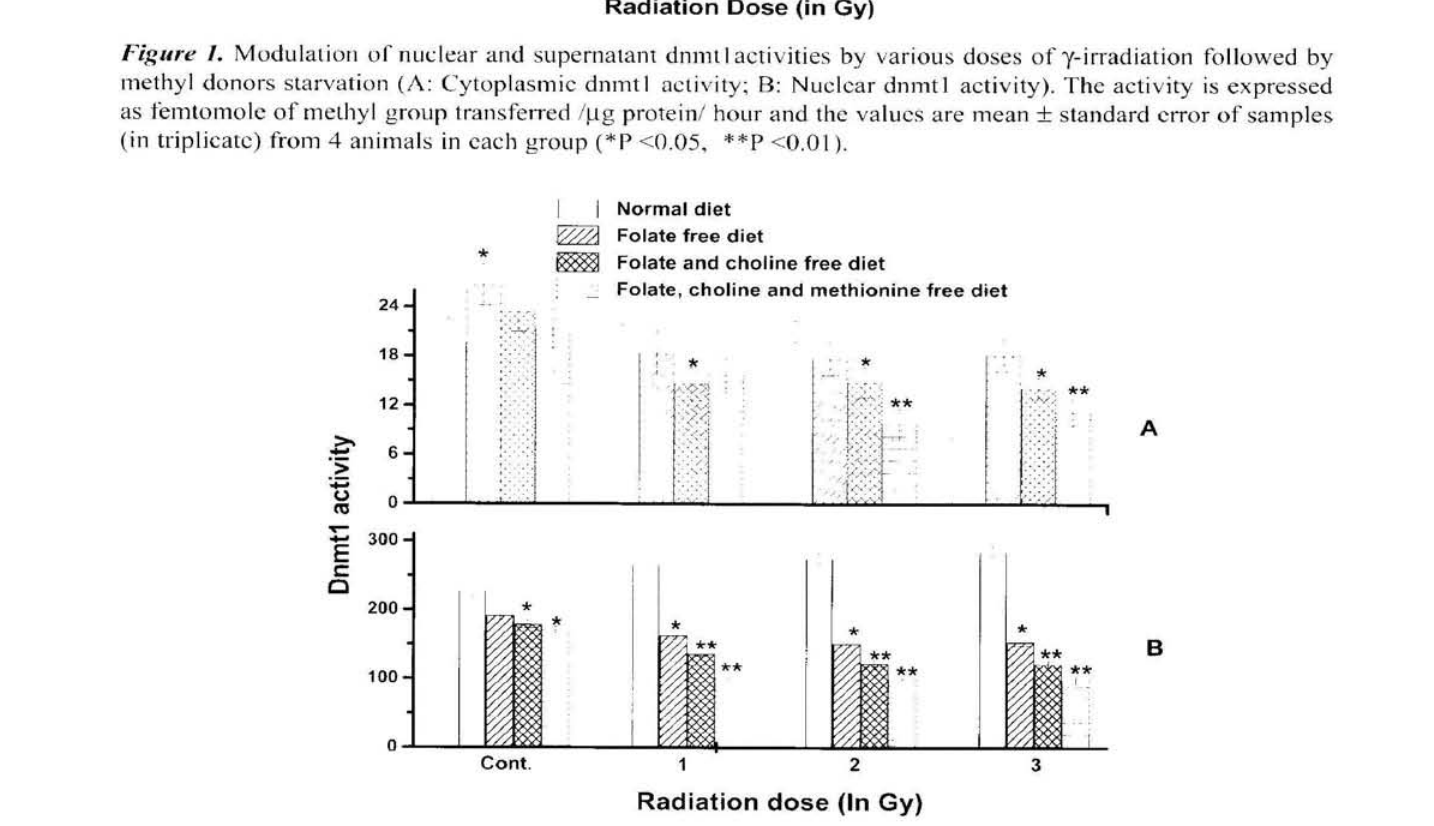
Figure 2. Modulation of nuclear and cytoplasmic dnmtl activity by various doses of γ-irradiation followed by complete methyl donors starvation using non-absorbable sulfonamide (A: Cytoplasmic dnmtl activity;